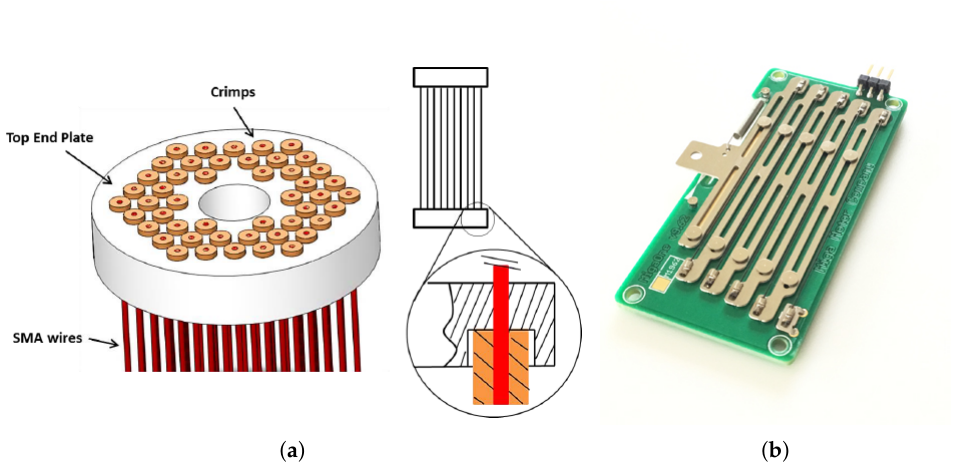
Figure 1. Different SMA-based actuator configurations. ( a ) Arrangement of SMA wires on end plate [13]; ( b ) MigaOnev SMA linear actuator